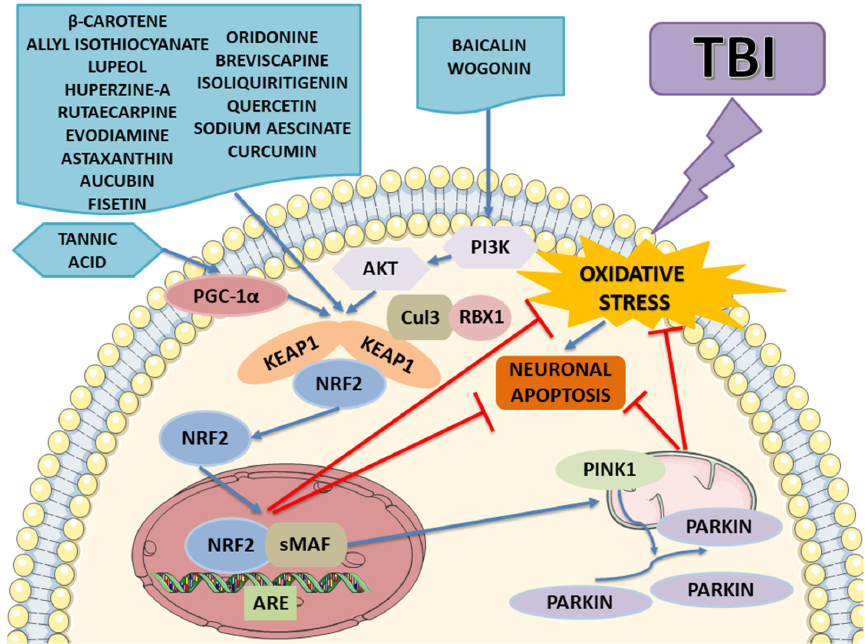
Figure 5. The potential molecular mechanism of natural compounds on TBI. These natural com- pounds can activate the expression of Nrf2 and facilitate Nrf2 ′ s translocation from the cytosol to the nuclear, thus, inhibiting oxidative stress and protecting from neuronal apoptosis. Tannic acid pos- itively regulates the protein expression of PGC-1 α , thereby activating the Nrf2/ARE pathway. In- stead, aicalin and wogonin increase the level of phosphorylated AKT and PI3K and activates Nrf2, which translocates into the nucleus to increase its downstream effectors’ production, which are responsible for anti-apoptosis and anti-oxidative effects, thus realizing the repair of TBI. The image was created using the image bank of Servier Medical Art (Available online: http://smart.servier.com/, accessed on 15 November 2022), licensed under a Creative Commons